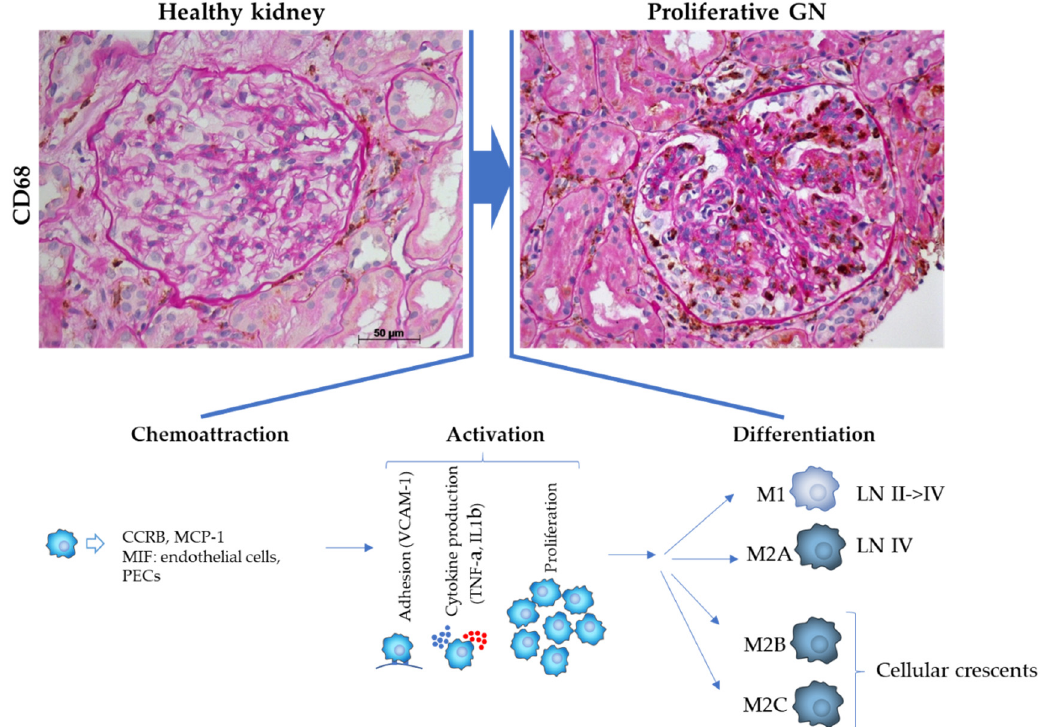
Figure 2. Representative images of healthy and proliferative glomeruli and schematic representation of pathophysiological processes involved in monocyte/macrophages transition occurring during disease onset and progression. Histological images labeled for CD68 (macrophages, brown) and counterstained with periodic acid-Schiff (PAS) staining (bar = 50µM).